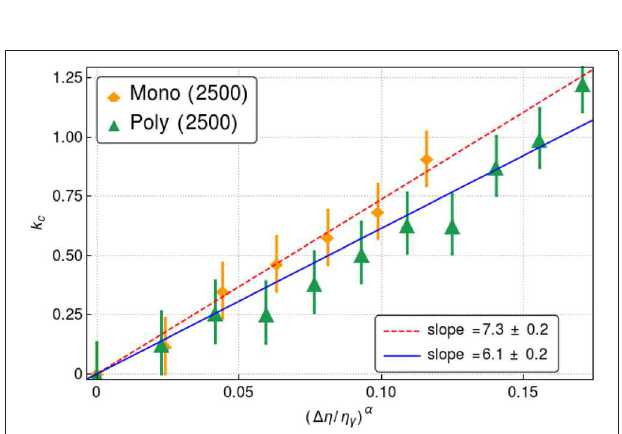
0.68 monodisperse =